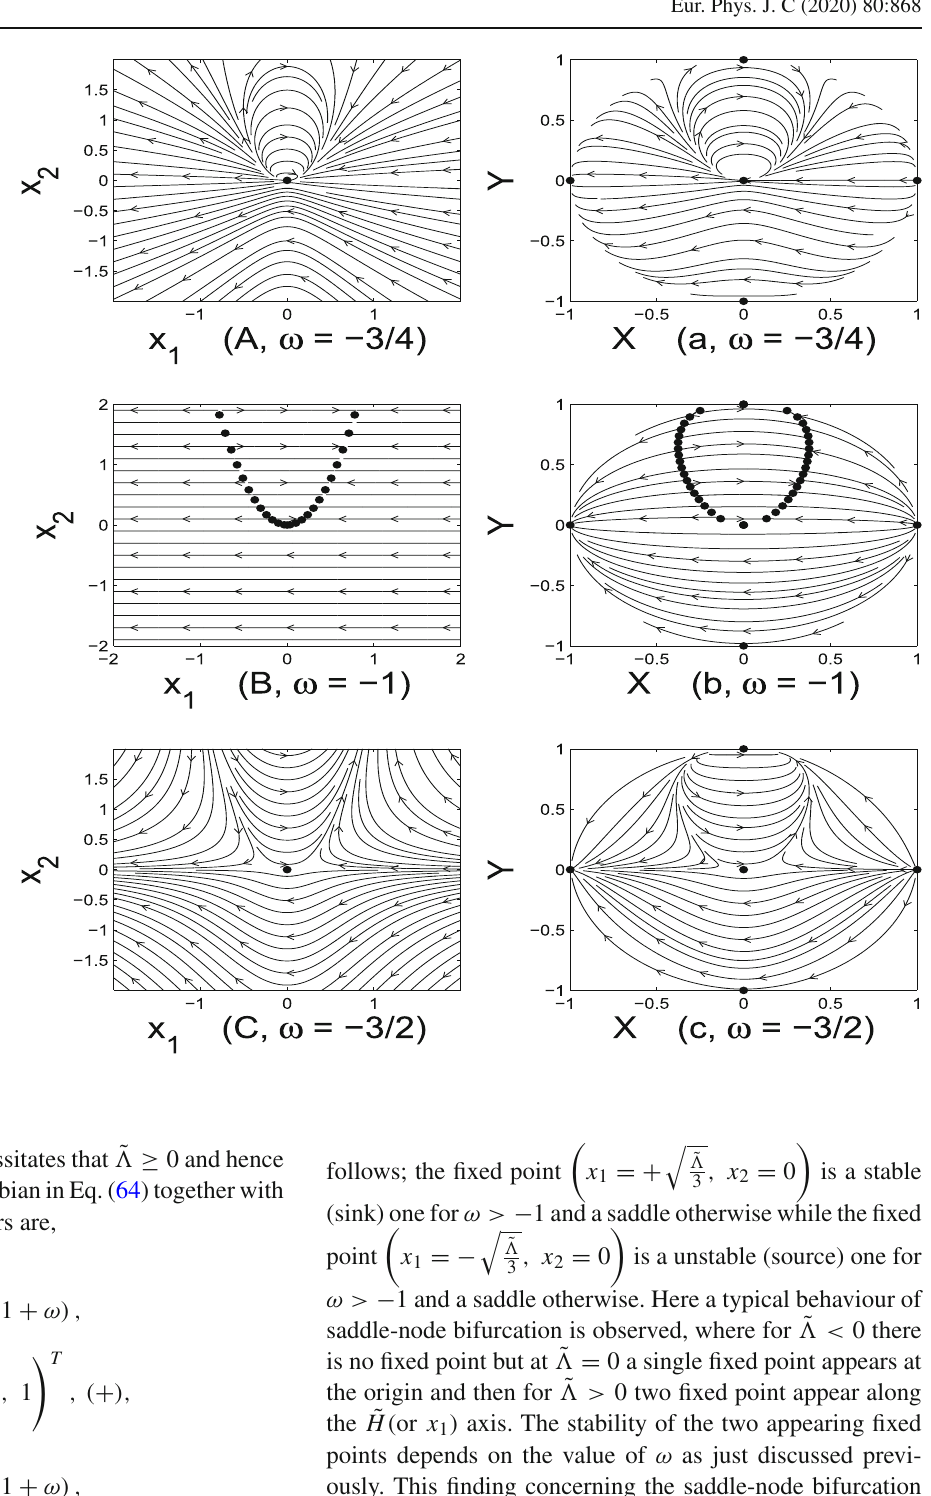
Fig. 5 Uncompact (left panel) and compact (right panel) phase portraits for the cases ω = − 3 , − 1 and − 3 . x 1 and x 2 4 2 respectively denote the dimensionless ˜ H and ˜ ρ as defined in Eq. (7). X and Y are the coordinates on the Poincaré sphere as defined in Eq. (47). The dotted circles represent fixed